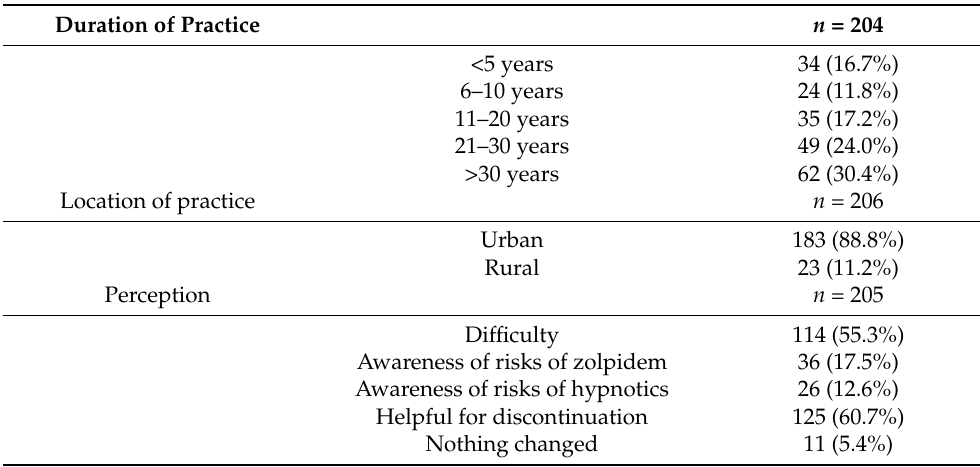
Table 1. Characteristics of respondents and perception toward the new regulation framework for